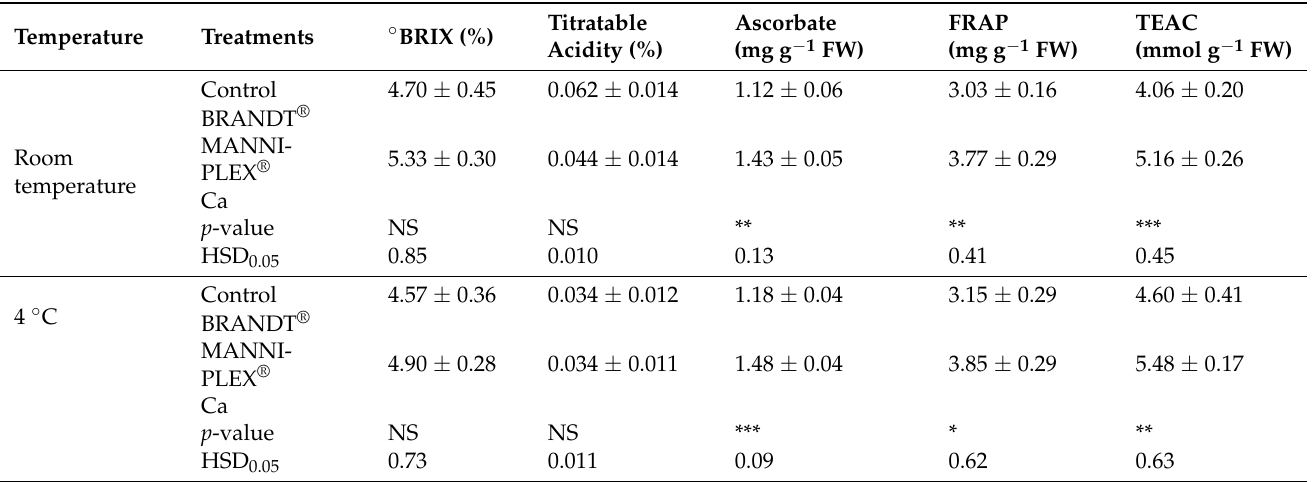
Table 5. Effect of BRANDT ® MANNI-PLEX ® Ca application products on some components of the quality of pepper fruits (organoleptic characteristics and antioxidant capacity) subjected to post- harvest at room temperature and 4 ◦